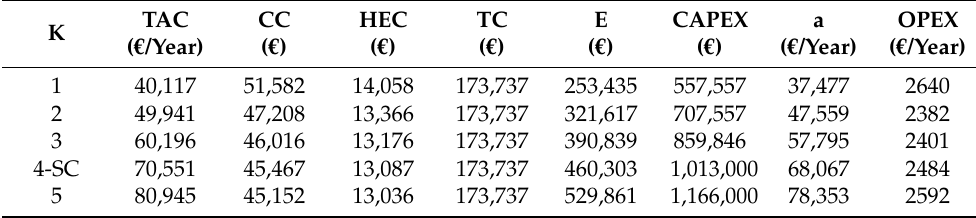
Table 5. Summary of the costs per scenario considering a storage pressure of 20 bar, CO 2 . K